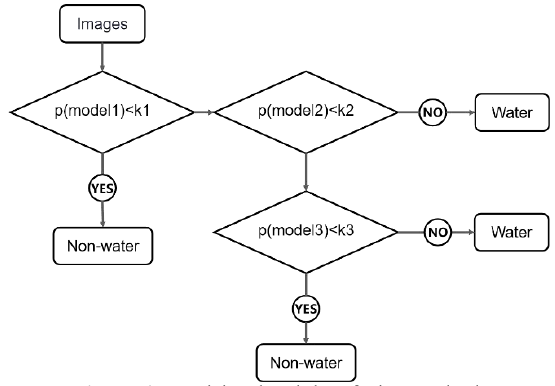
Figure 3 . UNet++ architecture(Zhou et al., 2018).